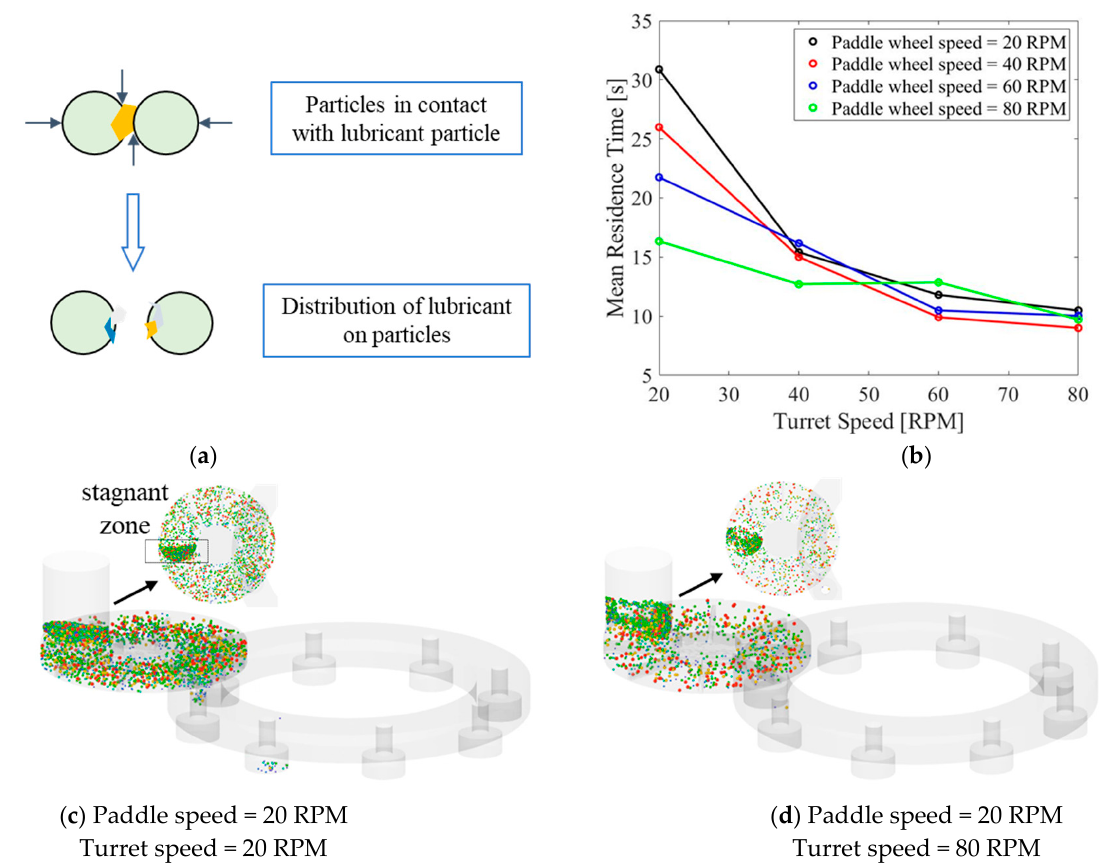
Figure 4. ( a ) Schematic showing the spread of lubricants on particles. ( b ) Effect of paddle speed and turret speed on the mean residence time of powder particles. ( c ) The state of the tracer particles when the simulation time is 30 s. Paddle speed = 20 RPM. Turret speed = 20 RPM. ( d ) The state of the tracer particles when the simulation time is 30 s. Paddle speed = 20 RPM. Turret speed = 80 RPM.